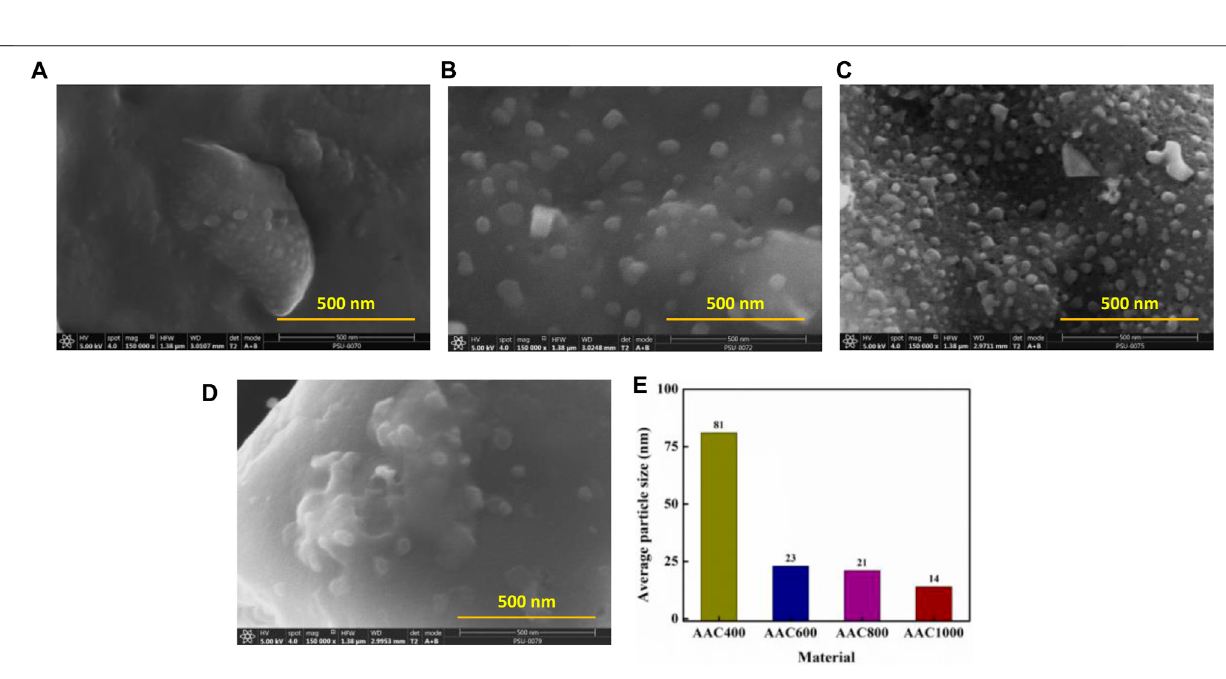
Frontiers in Energy Research |